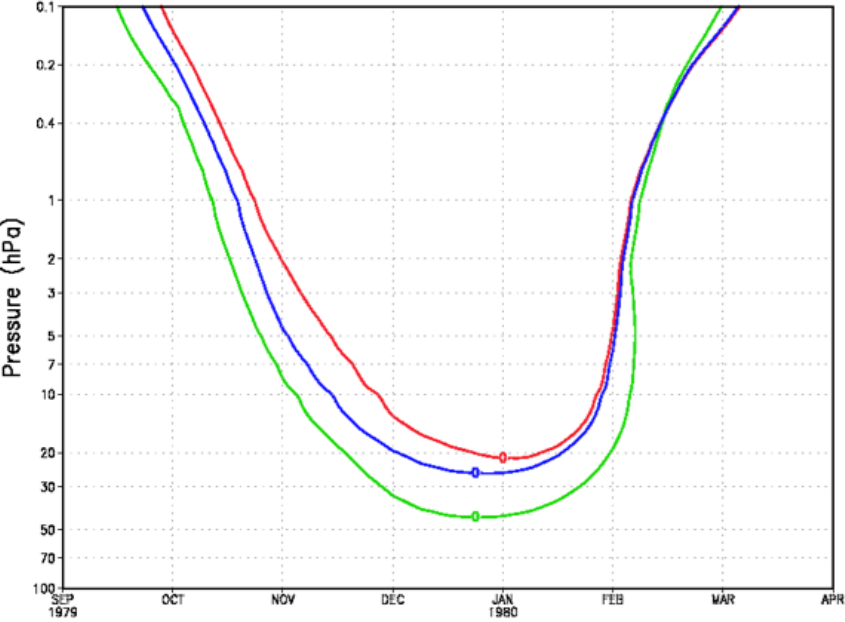
Figure 15. The annual cycle of the zero contour of the 30-year-averaged zonal mean zonal wind, averaged from 70 to 50 ◦ S latitude in ms − 2 from experiment 7 in red (MERRA AGCM-like), experiment 6 in blue (MERRA2 AGCM-like) and MERRA in